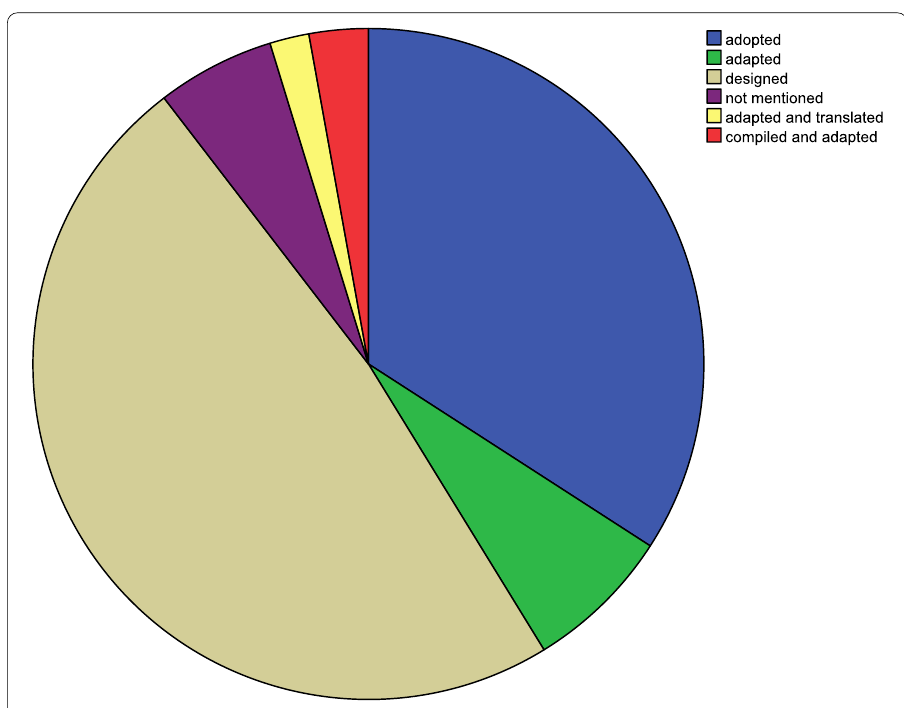
Fig. 1 Frequency of reporting instrument